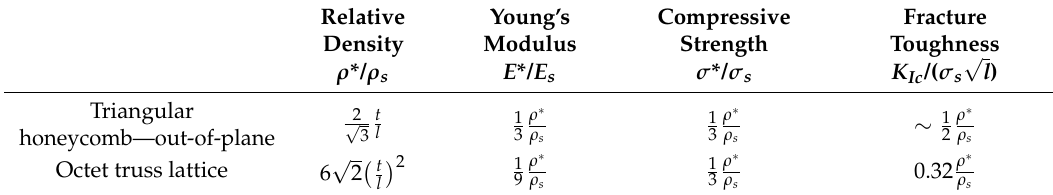
Table 1. Material property scaling for some cellular materials, from